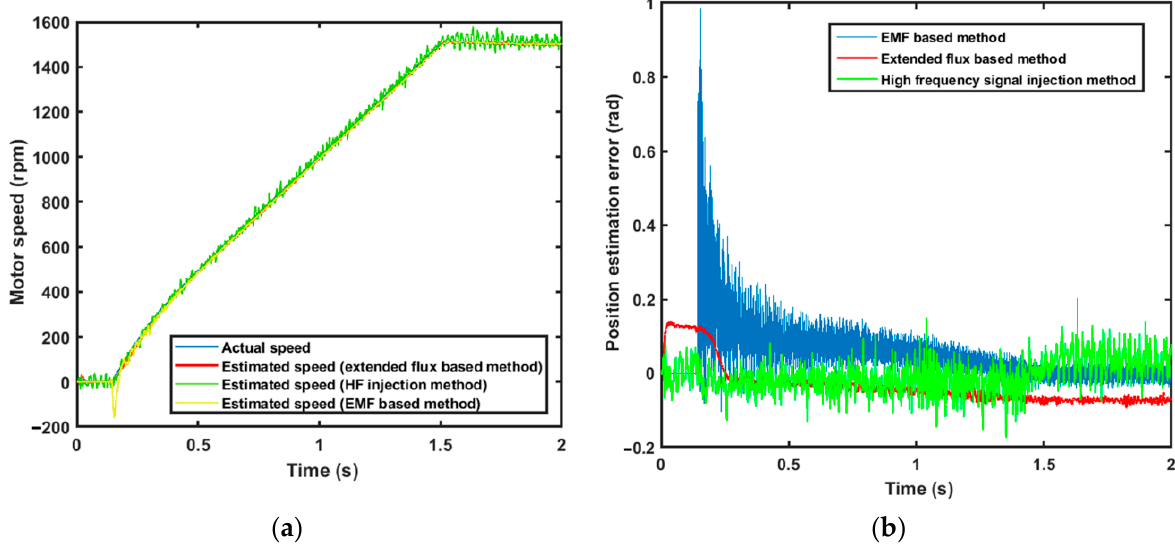
Figure 4. Comparison of the three mainstream rotor position estimation methods: ( a ) Speed estimation results over full speed range; ( b ) Rotor position estimation error over full speed range.